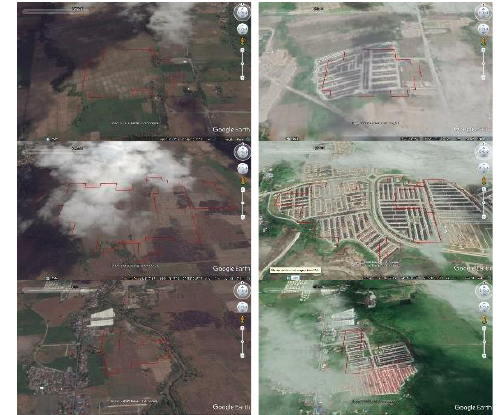
Figure 3. Samples of accurately classified regions-of-interest; From top to bottom: (a) Camella Bucandala, Imus, Cavite, (b) Lancaster Westwood, General Trias, Cavite, (c) Gentree